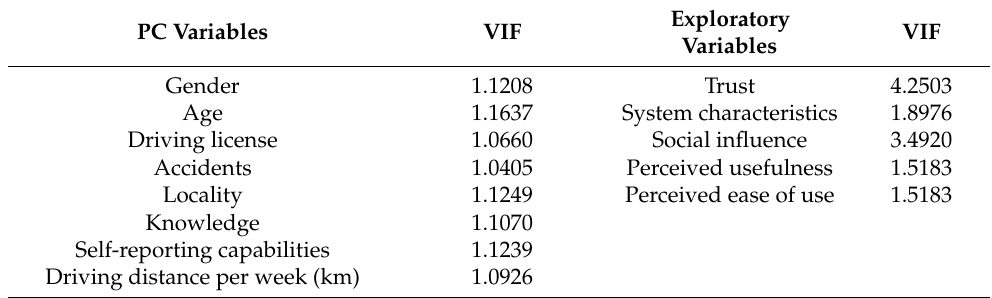
Table 11. Variance Inflating Factor (VIF).